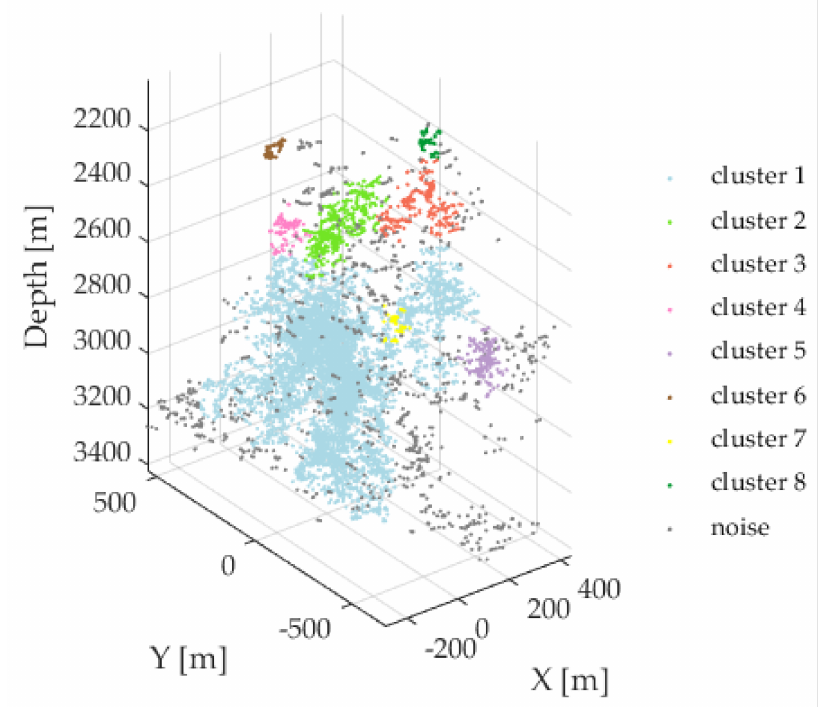
Figure 7. Results of the DBSCAN algorithm, whereby a cluster is deemed to comprise a minimum of 30 events within a neighborhood radius of 50